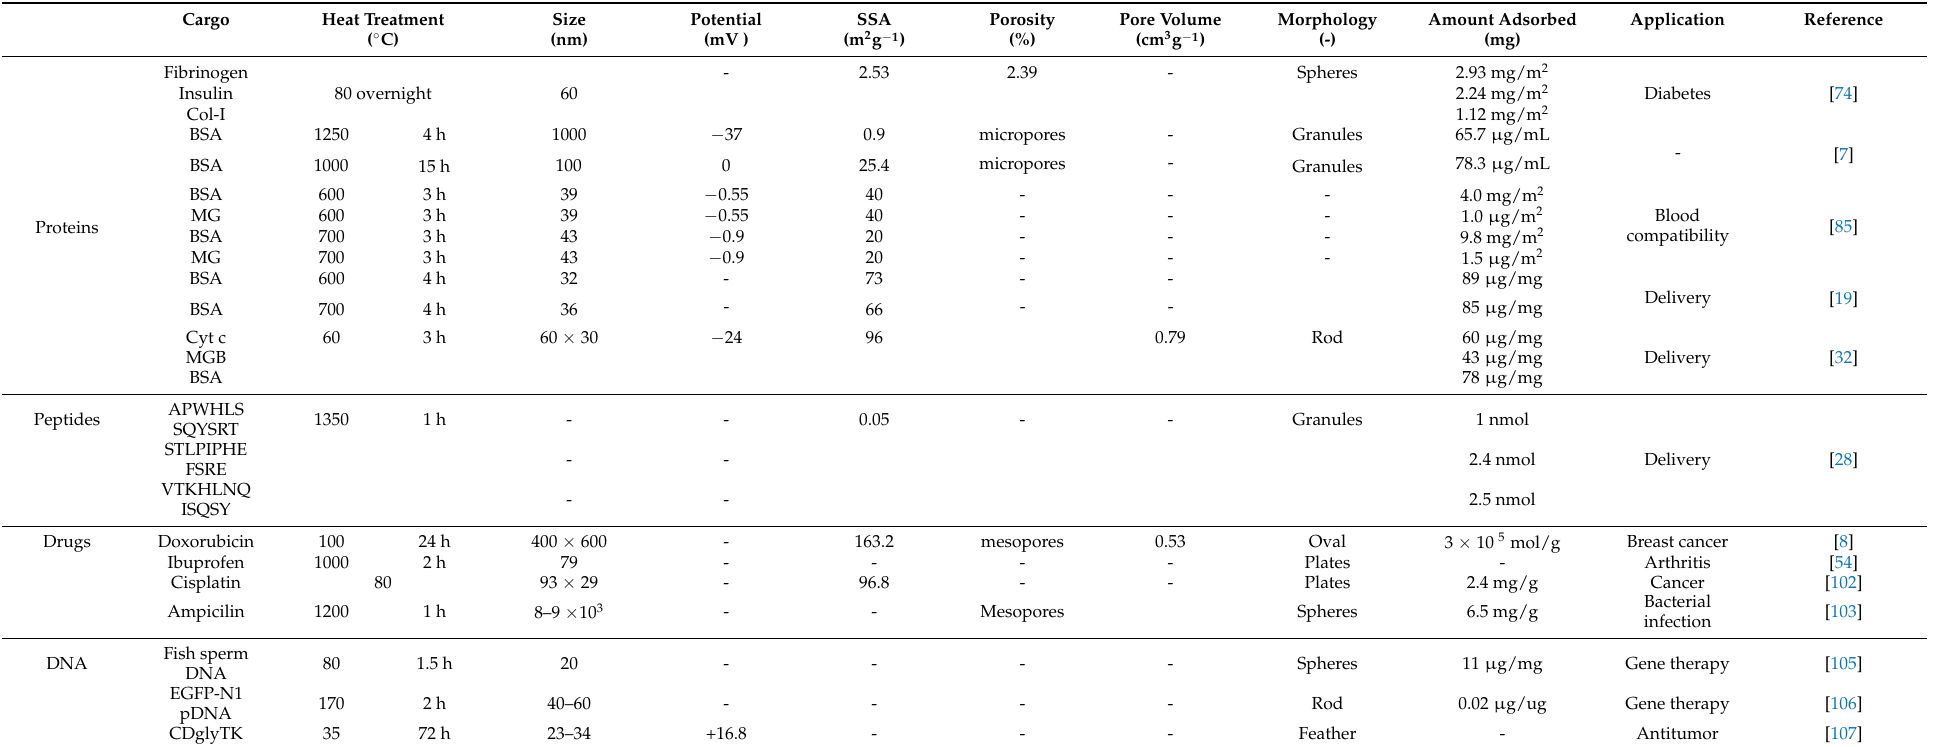
Table 4. Drug delivery applications for HAP and its respective